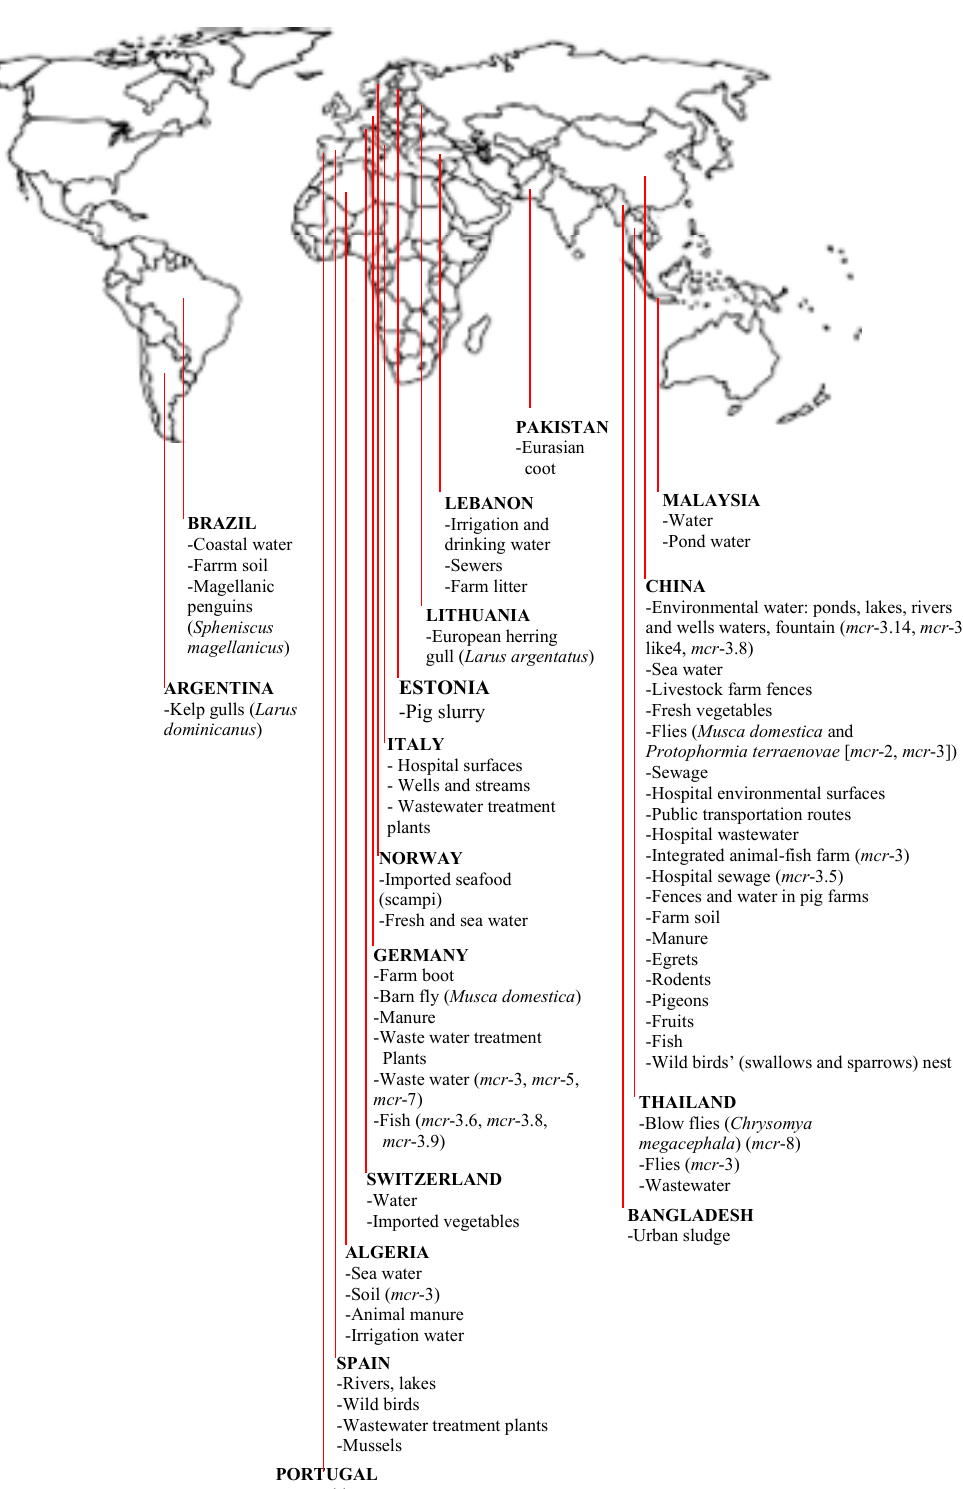
Figure 1. Countries in which mobile colistin resistance ( mcr ) gene mcr -1, including other mcr gene types indicated, have been detected in environmental (water, aquaculture, soil, plant, sewage, wastewater, and wildlife) reservoirs.